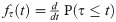
Relapse time densities fτ(t)=ddtP(τ≤t) computed from Eq 4 for logistic and exponential primary growths and ν = 10−10, 10−11, 10−12, 10−13, 10−14 cells/day from left to right.Using parameter estimates for colorectal cancer (see Table 2), the logistic densities (dashed lines) converge to the corresponding exponential ones as the initiation rate increases. Furthermore, in the exponential case and for all the above values of ν, the densities derived from Eq 4 and their approximation obtained from Eq 6 are indistinguishable.